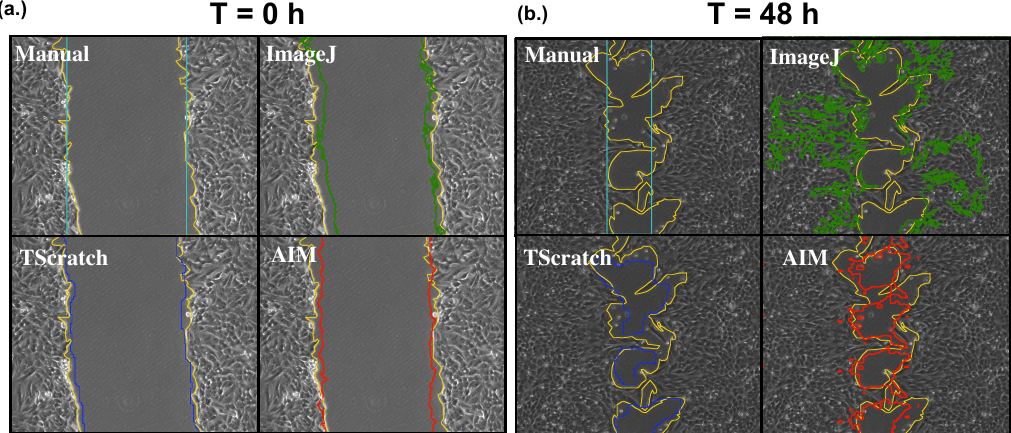
Figure 1. Schematization of the analysis here presented. The segmentation, with all the considered methods, of two representative images, acquired at T = 0 ( a ) and T = 48 h ( b ), is reported together with the true wound profile (in yellow). Cyan, green, blue and red represent the segmentations with, respectively, the manual method, imageJ, TScratch and AIM (Automatic Invasiveness